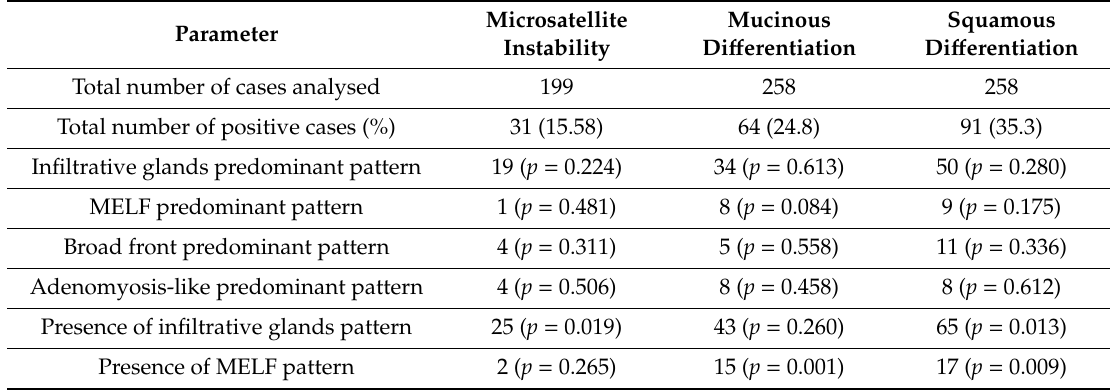
Associations between myoinvasive